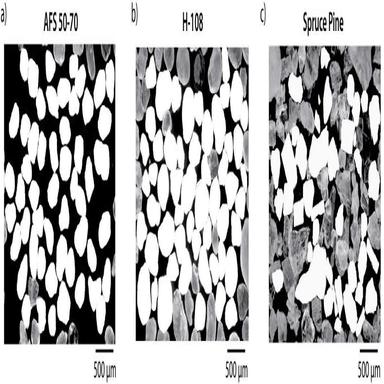
Computer-aided detection of individual particles (white shapes). (a) AFS 50–70, (b) H-108, (c) Spruce Pine.